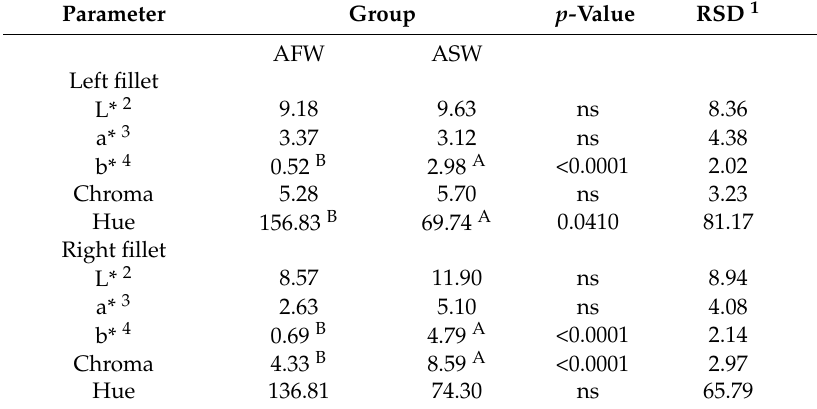
Table 3. Color of the left and right fillet of European sea bass reared in AFW and ASW. Parameter Group p- Value RSD 1 AFW ASW Left fillet